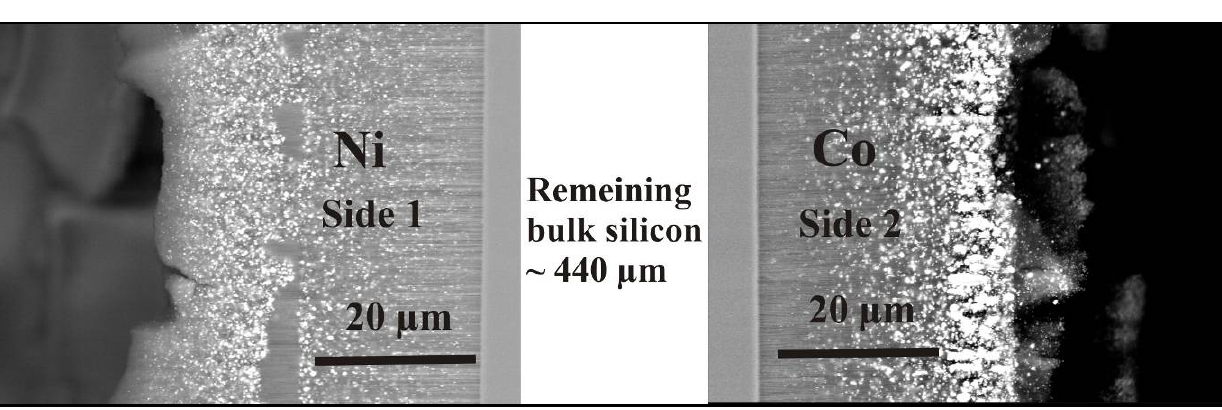
SEM-image, gained from back scattered electrons, of double-sided porous silicon with Ni deposited into the pores on one side and Co on the other side. The remaining bulk silicon between the layers is about 450 µm, the porous layers are around 30 µm